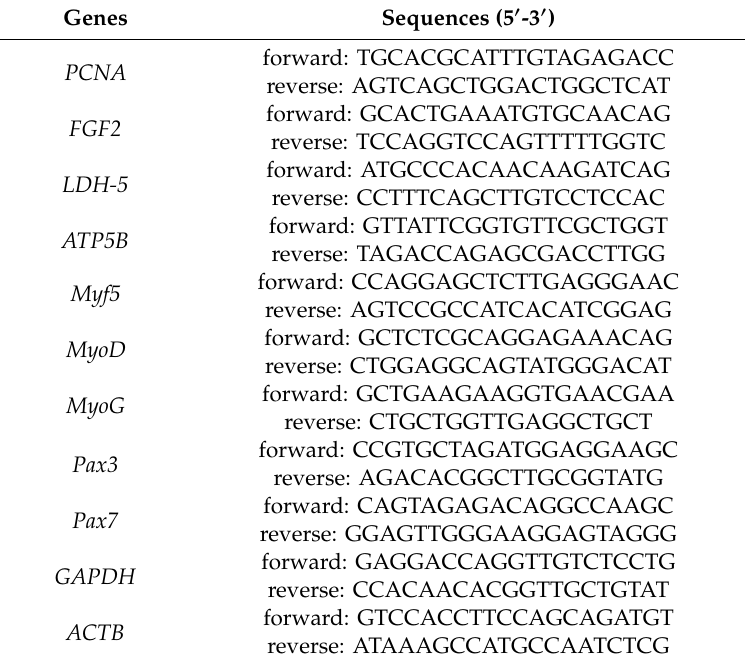
Table 2. Primers for gene expression analysis using